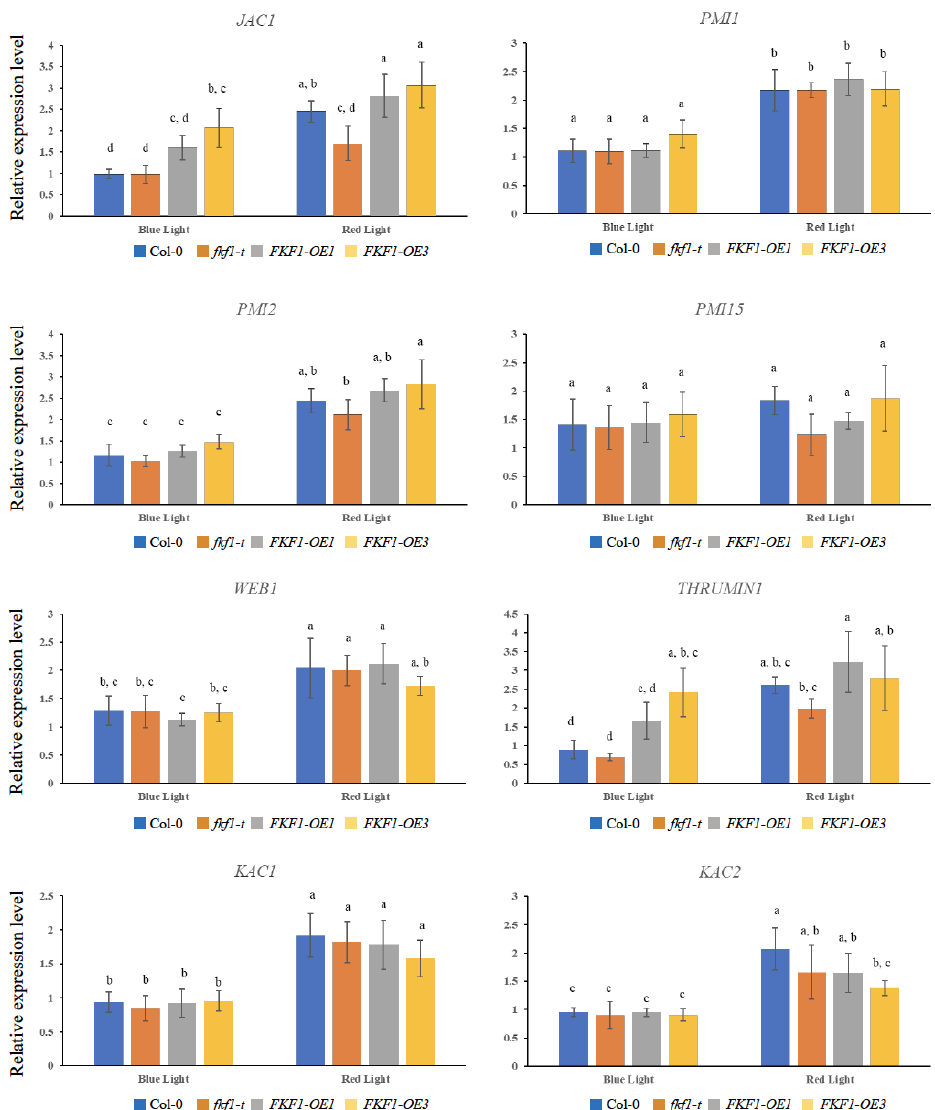
Figure 7. Expression analyses of critical genes involved in the chloroplast photorelocation under monochromatic red or monochromatic blue light . Arabidopsis plants grown under white light for 3 weeks were transferred to monochromatic blue light (25 µmol/m 2 /s) or monochromatic red light (25 µmol/m 2 /s) for 6 h (6 h after dawn). Leaf samples were then collected and used for qPCR analysis. The data are an average of two technical replicates from three biological replicates. Error bars represent S.D. ( n = 3). One-way ANOVA, followed by post-hoc analysis using Tukey’s test, was used to determine the statistically significant differences between Arabidopsis lines. Means not sharing the same letter are significantly different ( p < 0.05) or highly significantly different ( p < 0.01). Actin2 was used as a reference gene.